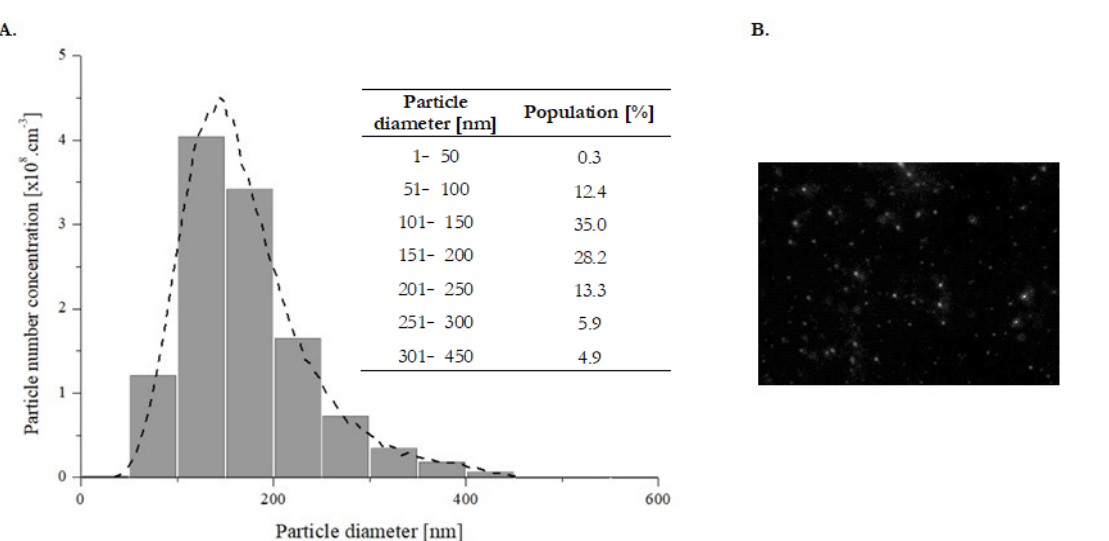
Figure 5. ( A ) Particle size distribution and percentage in various size ranges; ( B ) Representative capture of the corresponding video of isolated sEVs from concentrated MSCs-CM obtained by NTA ( n = 4). The captured area of the microscopic image was 80 × 100 µm while the focal depth was approximately 20 µm.